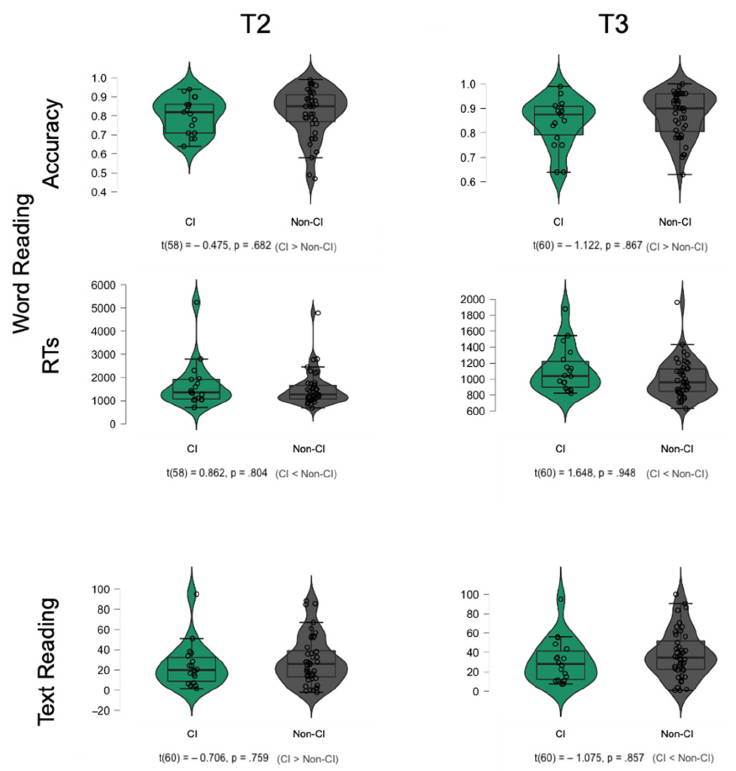
Figure 2. Response distributions and results from the independent sample t -tests for deaf children with and without CI at all the study measures.